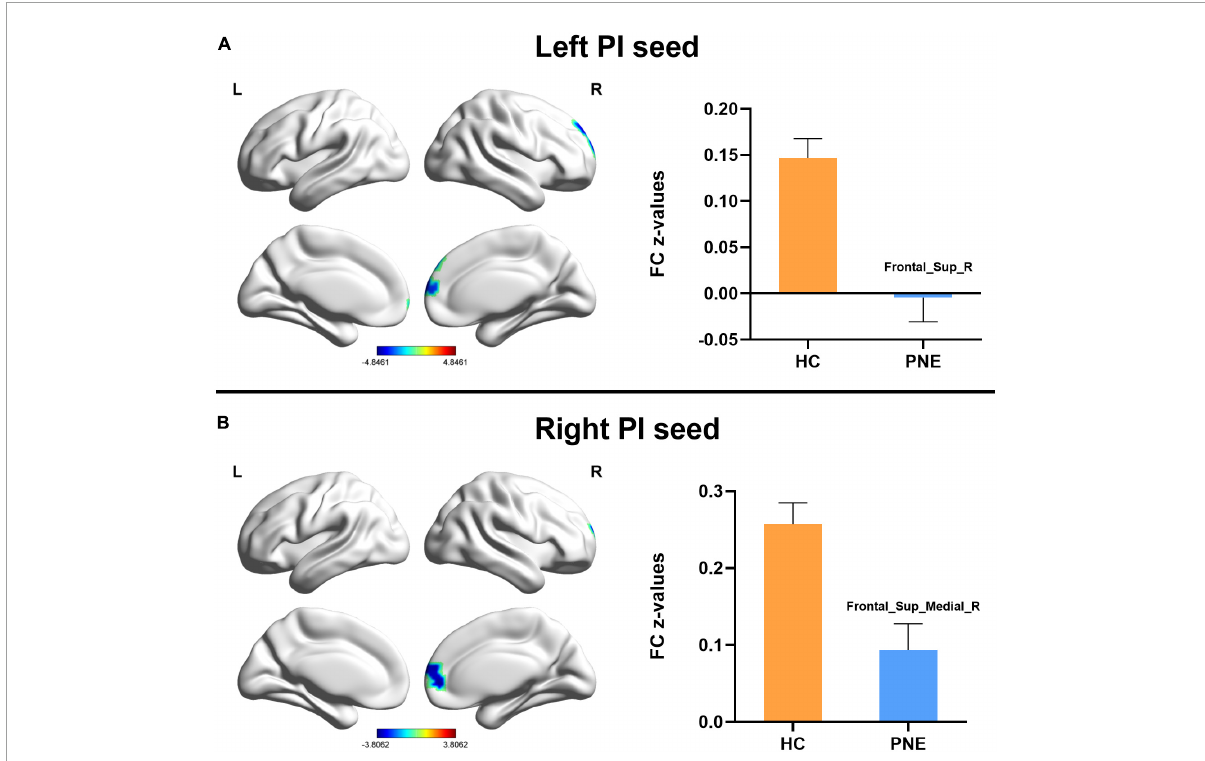
FIGURE3 Comparisons of the posterior insula-centered functional connectivity between PNE and HC children. The (A) left PI seed indicated reduced functional connectivity with Frontal_Sup_R, while the (B) right PI seed showed decreased functional connectivity with Frontal_Sup_Medial_R (two-tailed GRF correction, P < 0.005 at single voxel, and P < 0.05 at cluster level). PNE, primary nocturnal enuresis; HC, healthy control; PI, posterior insula; Frontal_Sup_Medial, medial superior frontal gyrus; Frontal_Sup, superior frontal gyrus; L, left; R, right. Color scales: t -value; Error bars: